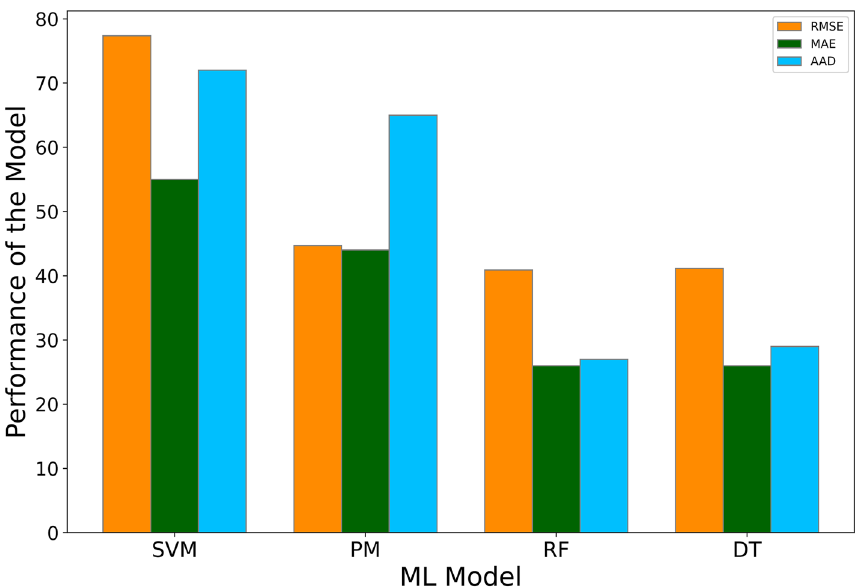
Fig. 4 Statistical evaluation metrics across the selected ML